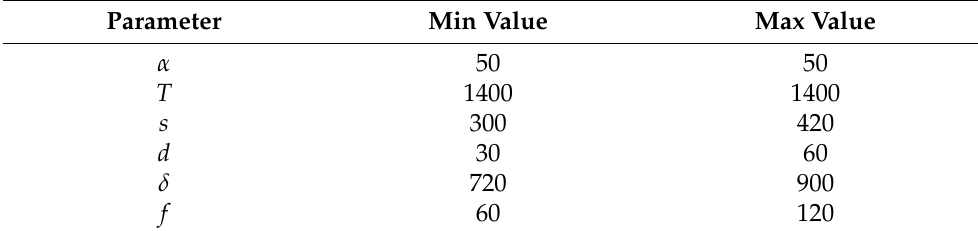
Table 1. Parameters used to generate the synthetic problem instances.